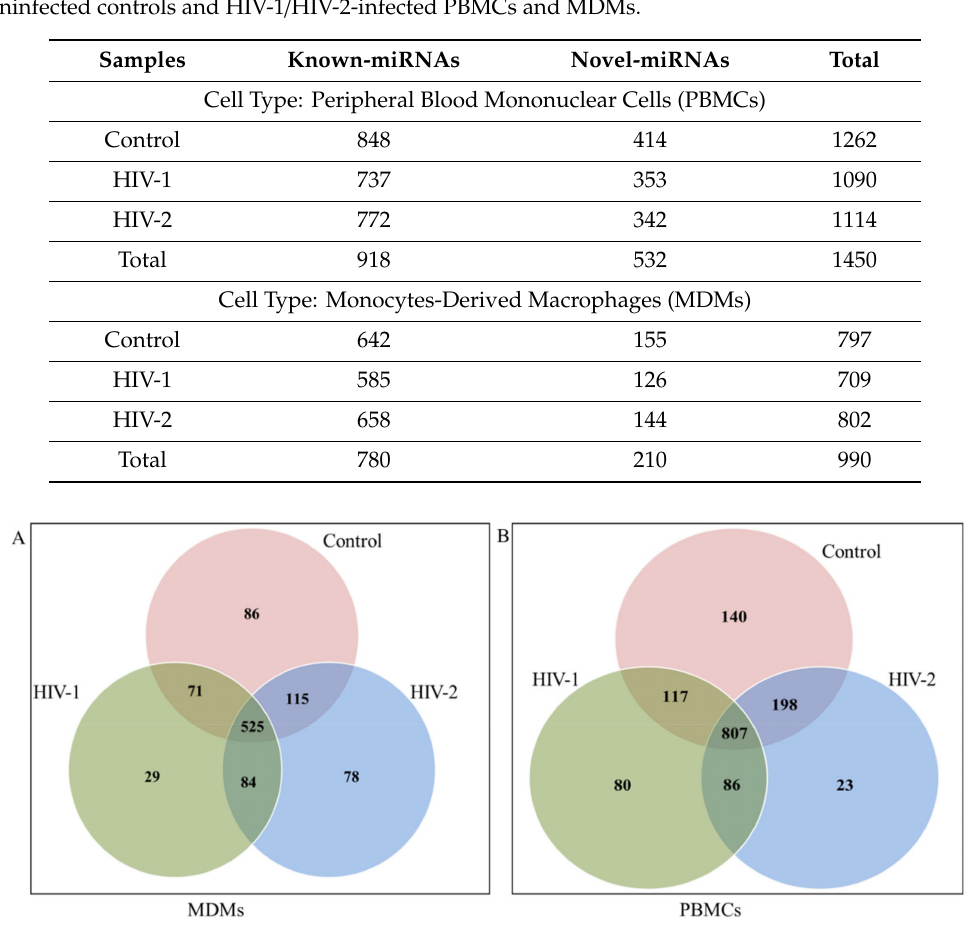
uninfected controls and HIV-1 / HIV-2-infected PBMCs and MDMs.